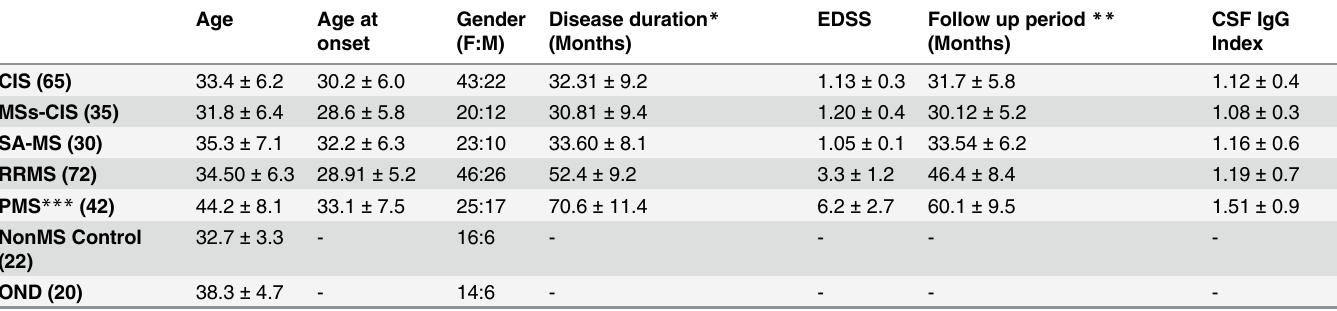
Table 1. Clinical and demographical data of study